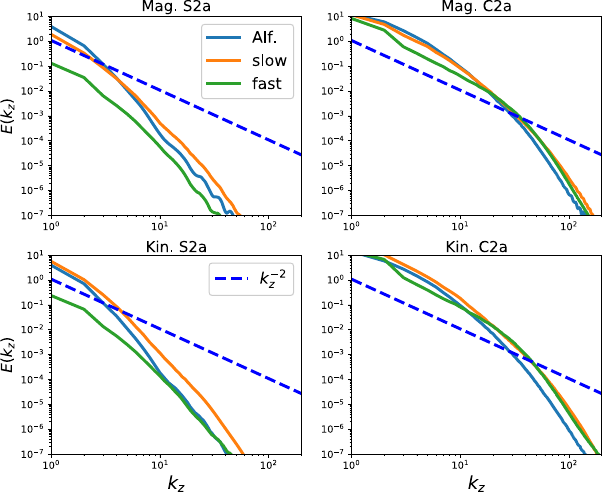
FIG. 14. The parallel wave-number spectrum for the three modes for S2a simulation (left panels) and C2a simulation (right panels), with magnetic fields (top panels) and velocity fields (bottom panels). The legends apply to all